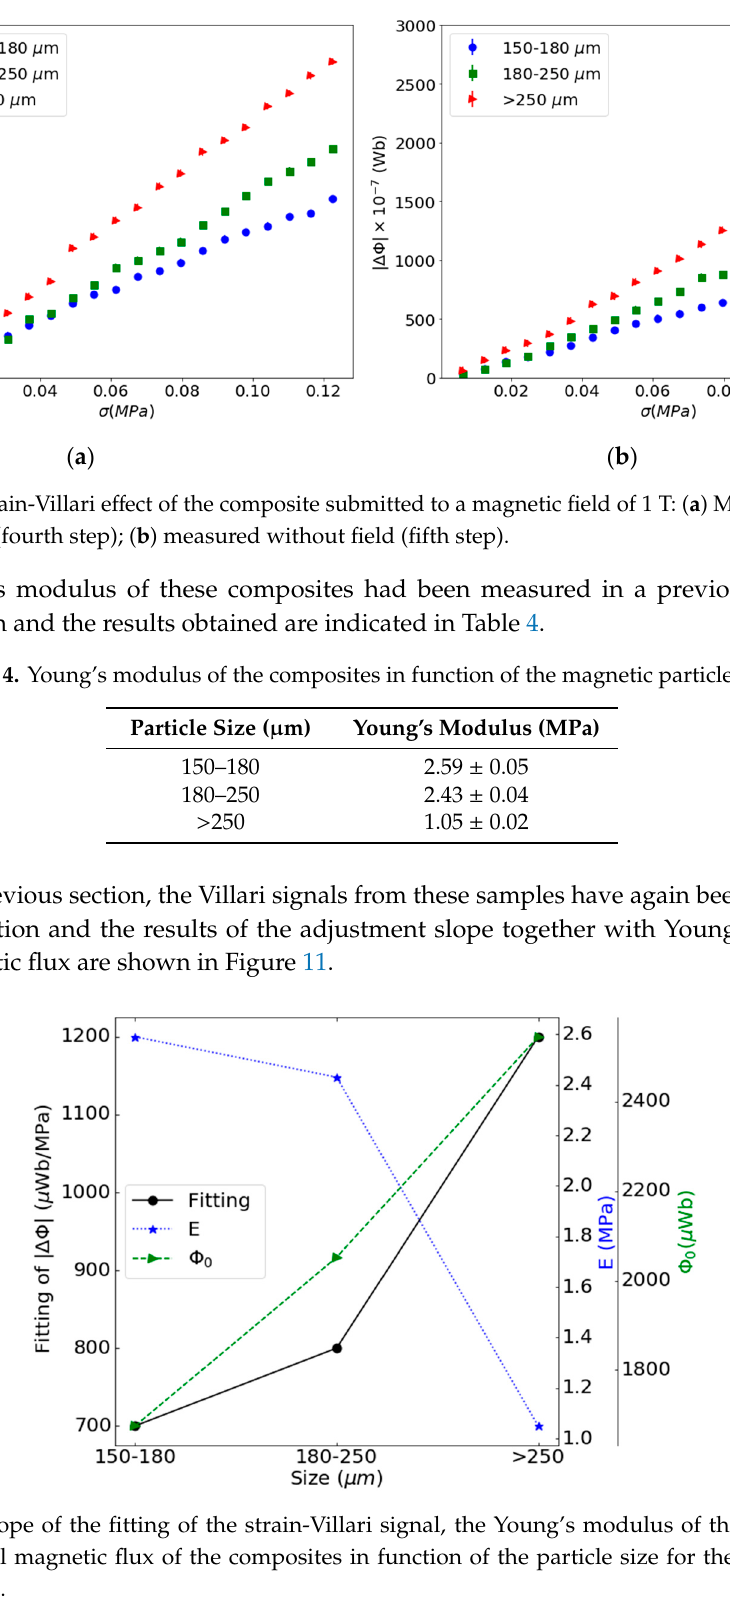
Figure 11. Slope of the fitting of the strain-Villari signal, the Young’s modulus of the composites and the initial magnetic flux of the composites in function of the particle size for the fifth step of the